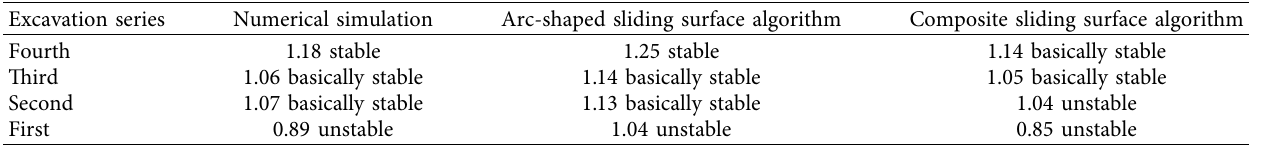
Table 3: Comparison of slope stability results of diferent methods.